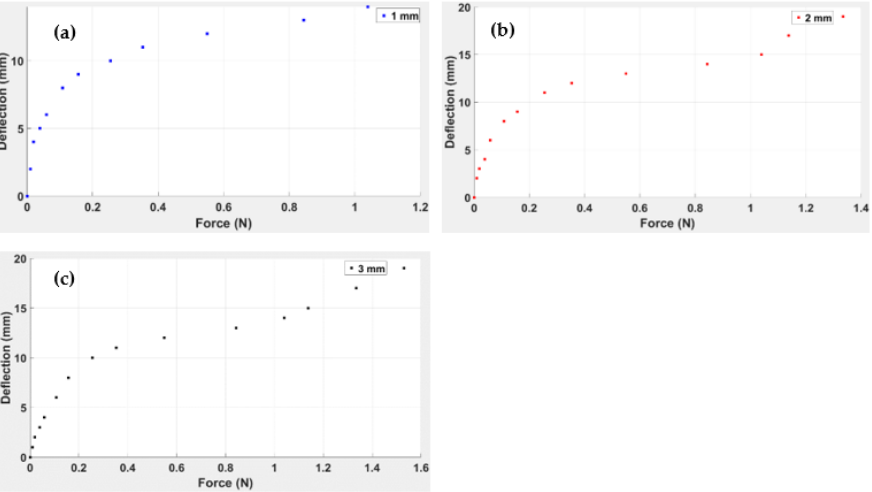
Figure 14. Deflection of an origami TPU “cross” capsule acting as a cantilever beam as a function of force for “capsule” thicknesses: ( a ) 3 mm, ( b ) 2 mm and ( c ) 1 mm.